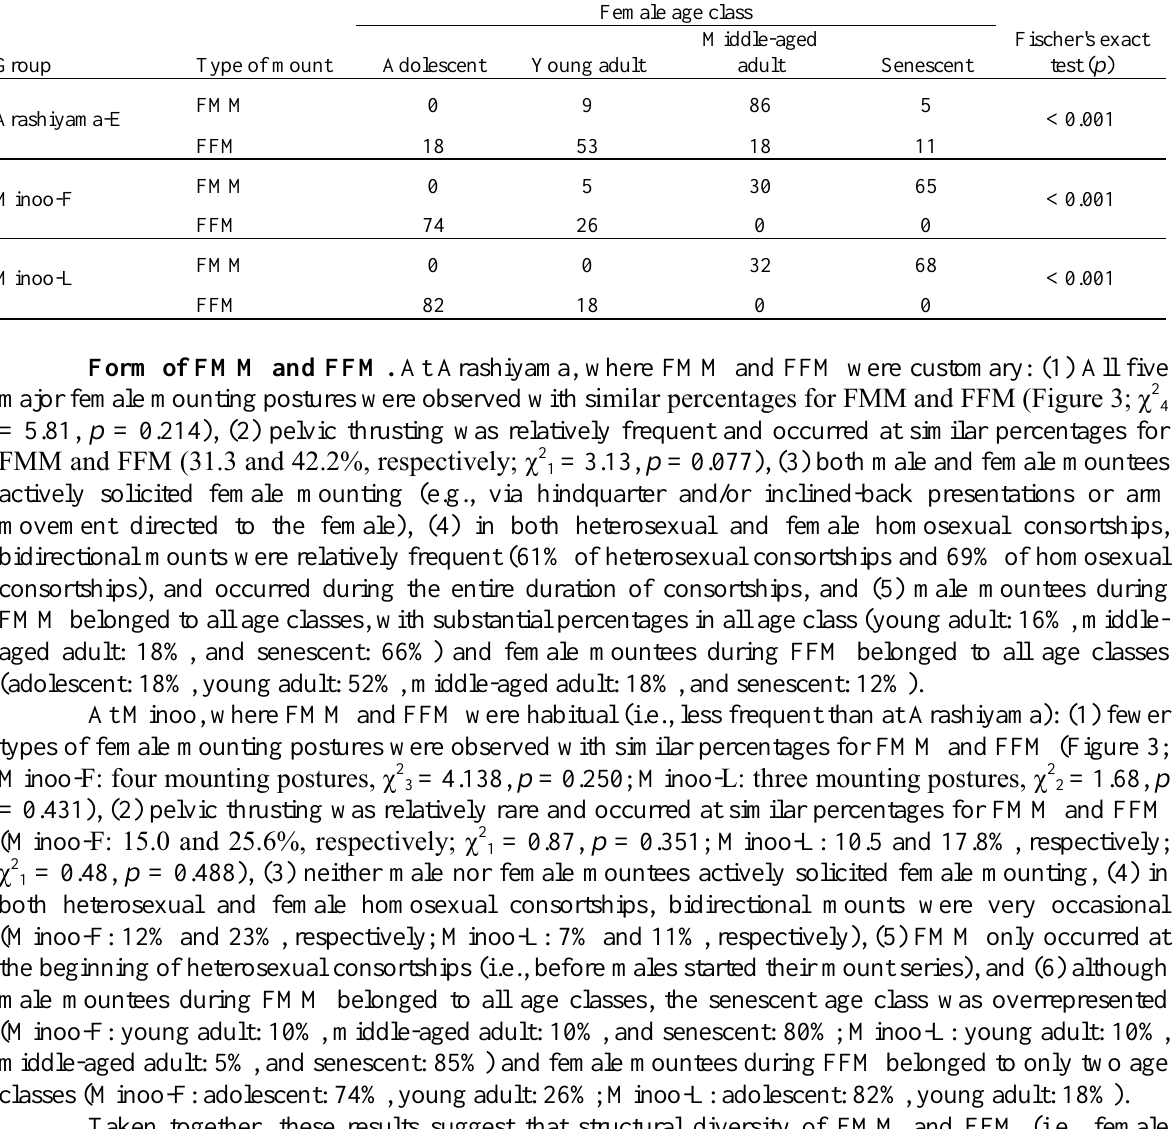
Percentage of FMM and FMM Performed by Females of Different Age Classes Across Study Groups FMM 0 9 86 5 Arashiyama-E FFM 18 53 18 11 FMM 0 5 30 65 Minoo-F FFM 74 26 0 0 FMM 0 0 32 68 Minoo-L FFM 82 18 0